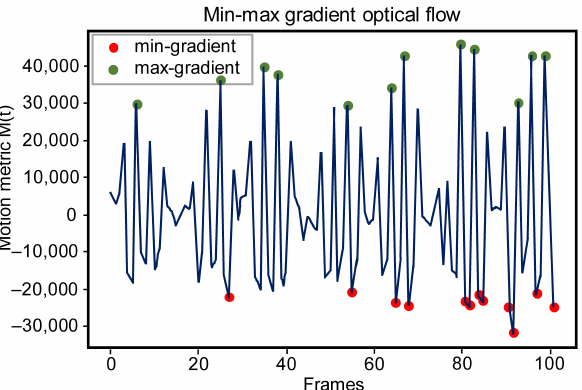
Figure 6. The selected k frames for a video from the UCF Sports dataset, labeled as a walking video based upon the highest k values of the gradient of the total motion metric. The red dots show the local minima, whereas the green dots show the local